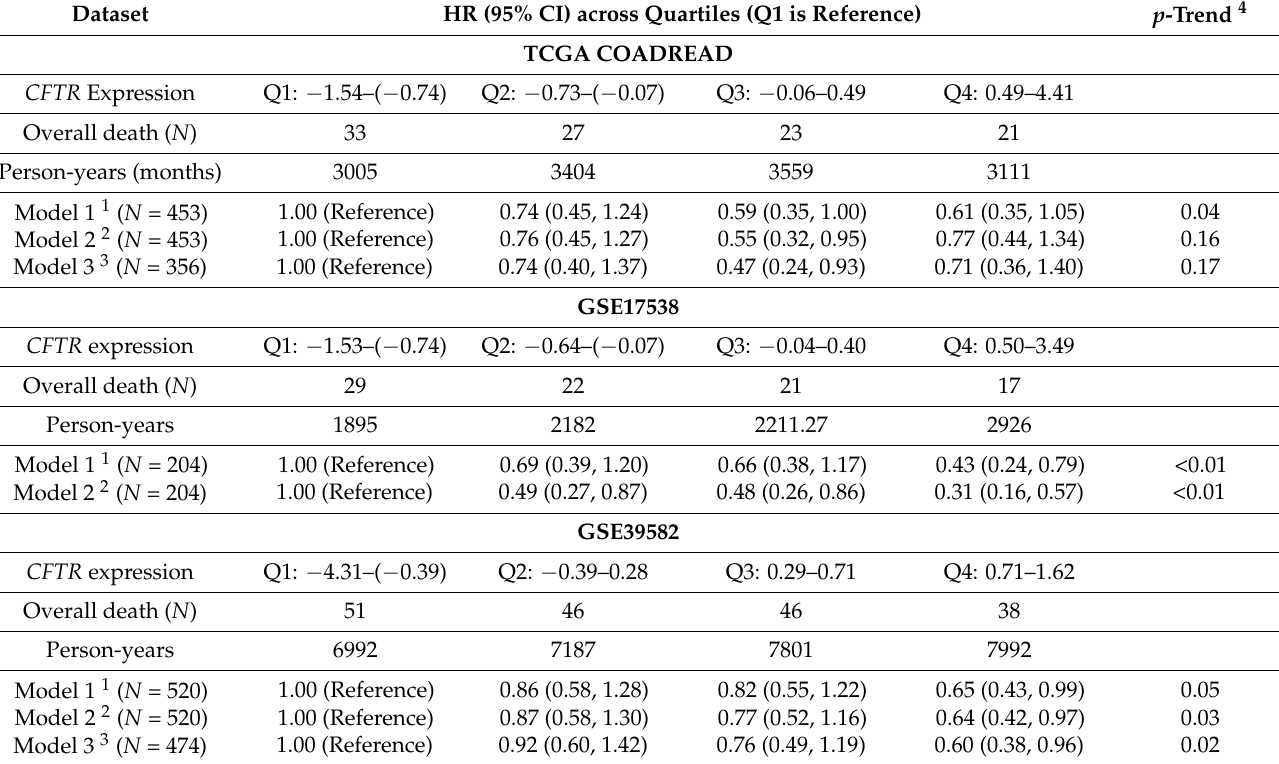
Table 2. Hazard ratio (HR) and 95% confidence interval (CI) for overall death in relation to CFTR mRNA expression, presented as quartiles in individuals with CRC/colon cancer in the TCGA COADREAD, GSE17538, and GSE39582